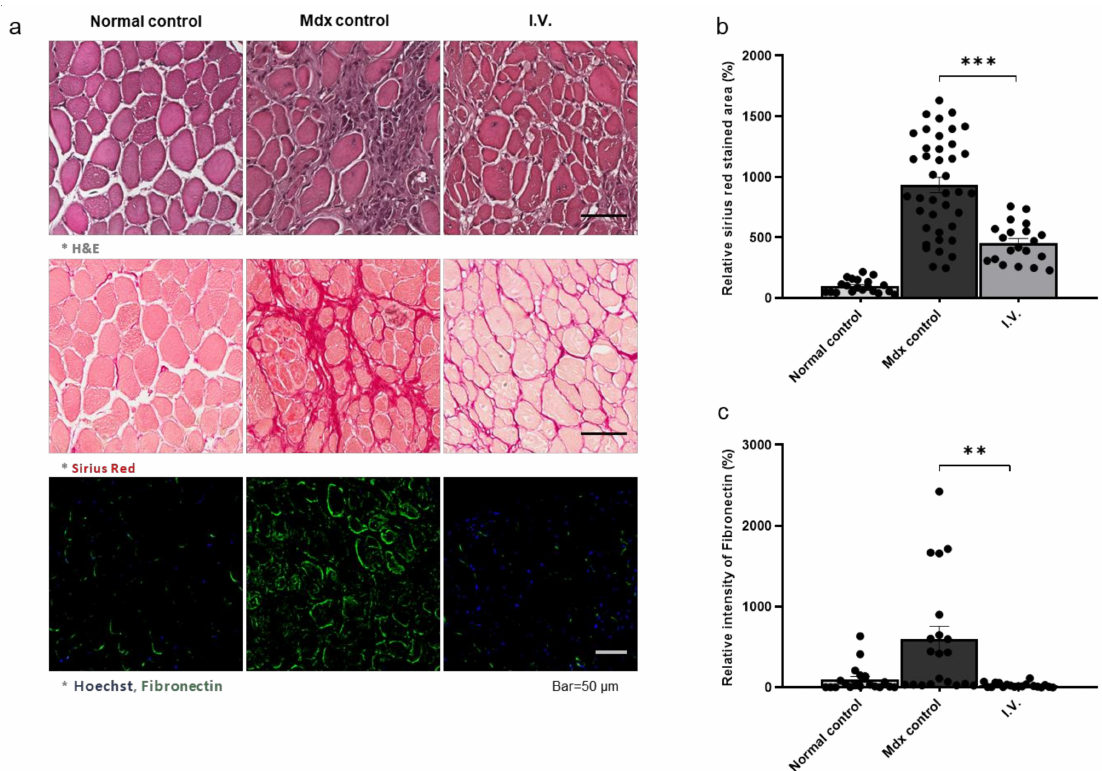
Figure 5. Antifibrotic effect of Wharton’s jelly-derived mesenchymal stem cells in the diaphragm of mdx mice ( a ) Repre- sentative images of H&E and Sirius red staining and immunohistochemistry for fibronectin detection. ( b , c ) Quantitative measurements were performed in ImageJ, and the data are expressed as the mean ± SEM. Bars with different superscripts indicate significantly different values (** p < 0.01, *** p <